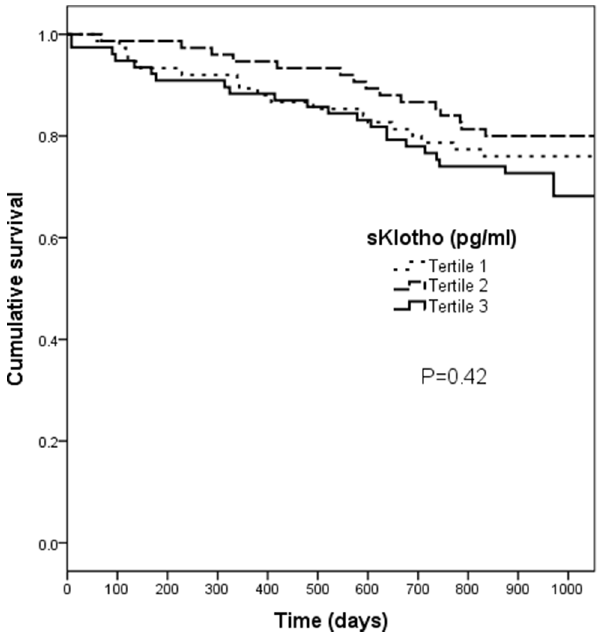
Figure 1. Cumulative survival by tertiles of secreted Klotho. Patients were stratified by their baseline Klotho levels according to the tertiles. Kaplan-Meier analysis with long-rank test did not reveal a significant difference between groups (P=0.42).